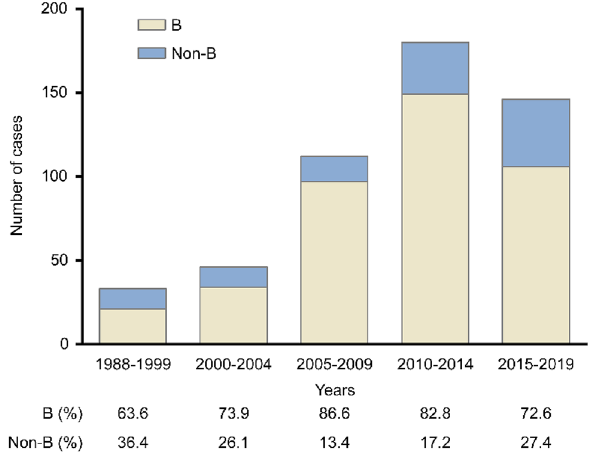
Figure 1. Changes in the proportion of HIV subtypes B and non-B subtypes among 517 patients with HIV infection over time, stratified by the year of HIV diagnosis.